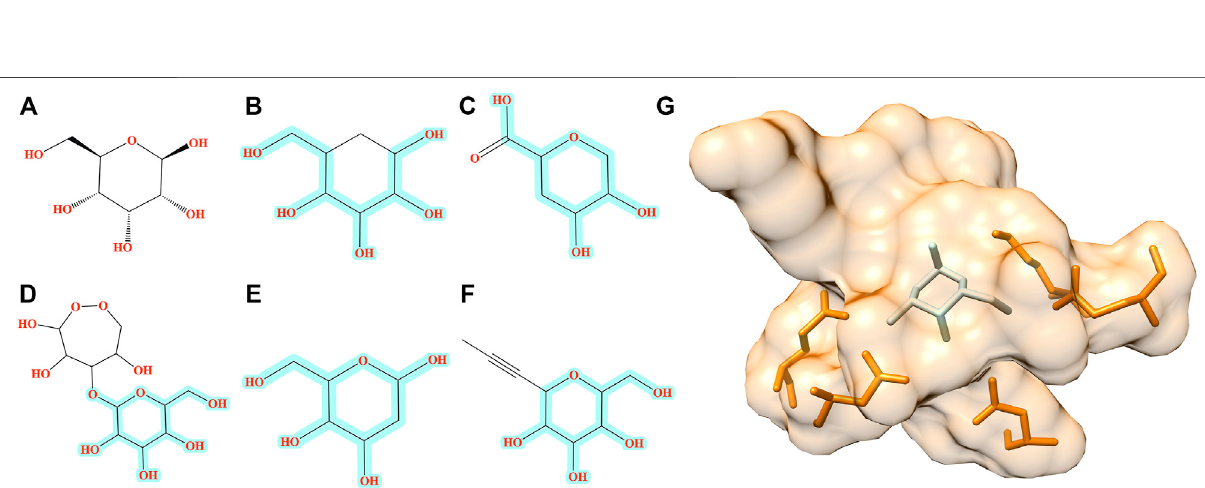
FIGURE 5 | Examples of molecules generated by Pocket2Drug for a binding site in MSK1. (A) The label ligand, AMP-PNP. (B – F) Molecules constructed by Pocket2Drug with maximum common substructures to the label ligand highlighted in cyan. (G) Molecule shown in B (ice blue) docked to the binding site in MSK1 (orange).